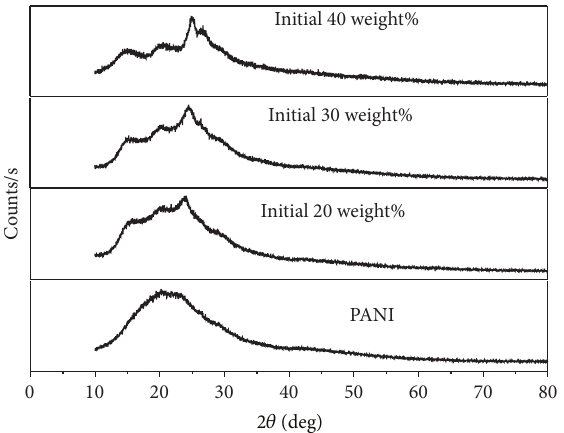
Figure 5: Dielectric loss ( 𝜀 󸀠󸀠 ) versus frequency at fixed temperature (302 K) for pure PANI and PANI/V 2 O 5 composites (different weight %).